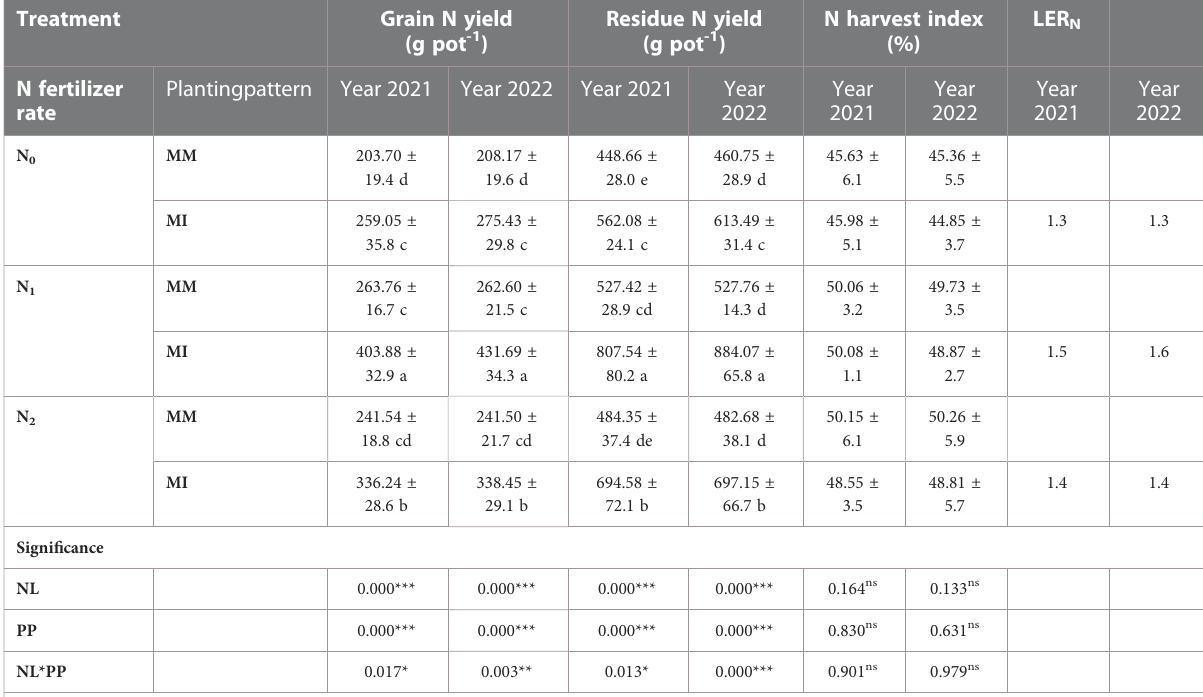
TABLE 2 Grain N yield, residue N yield, N harvest index and LER N of maize crop as in fl uenced by different planting patterns (MM, maize mono- cropping and MI, maize intercropping) and N fertilizer application rates (N 0 ; 0 kg N ha -1 , N 1 ; 250 kg N ha -1 and N 2 ; 300 kg N ha -1 ) in 2021 and 2022 crop growing